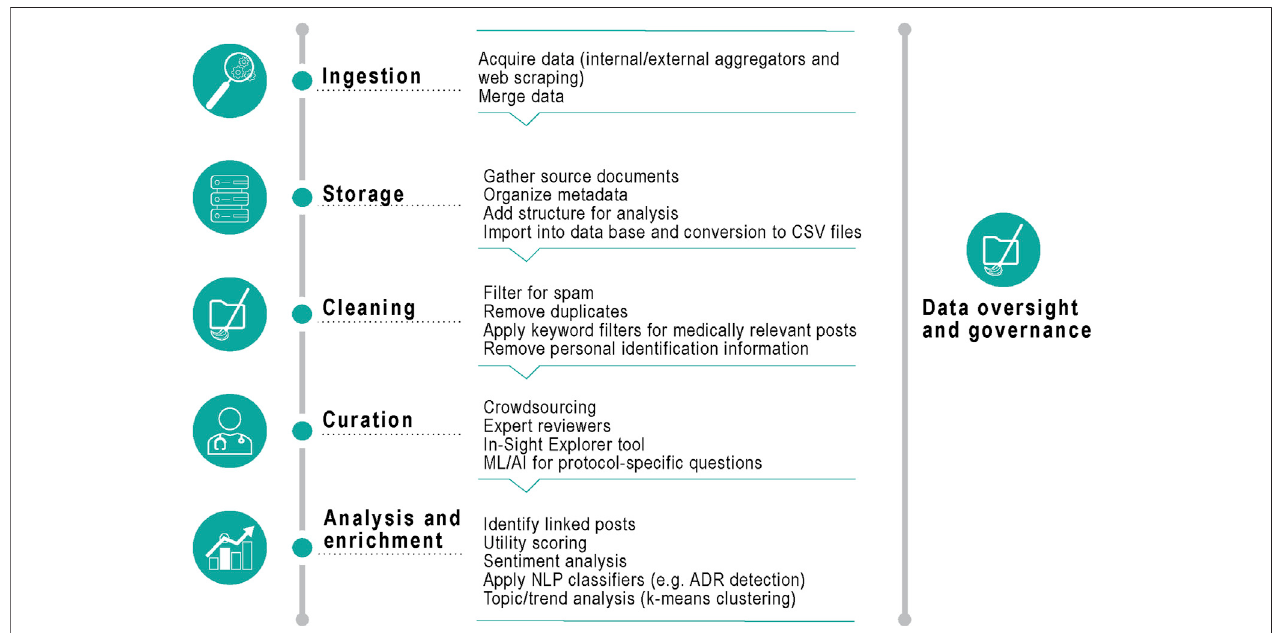
FIGURE1| Dataprocessing.CSV,CommaSeparatedValue;ML,machinelearning;AI,arti fi cialintelligence;NLP,naturallanguageprocessing;ADR,adversedrug reactions.